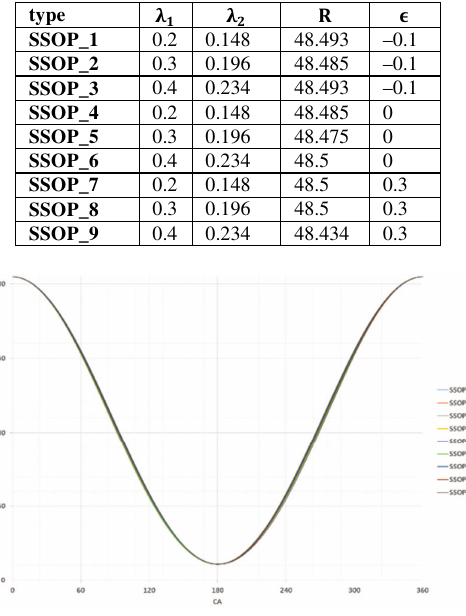
Fig. 10. SSOP piston motion curves